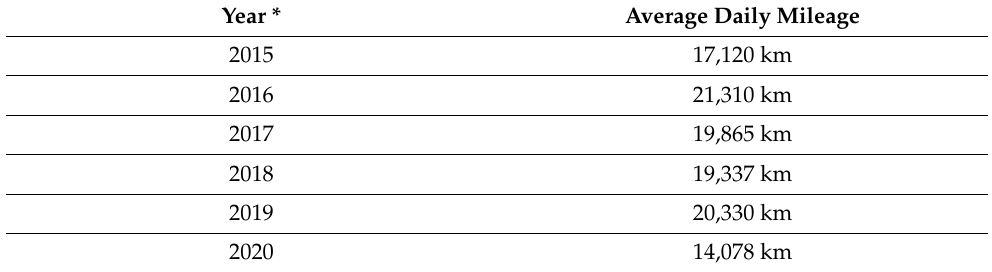
Table 4. Average daily mileage.